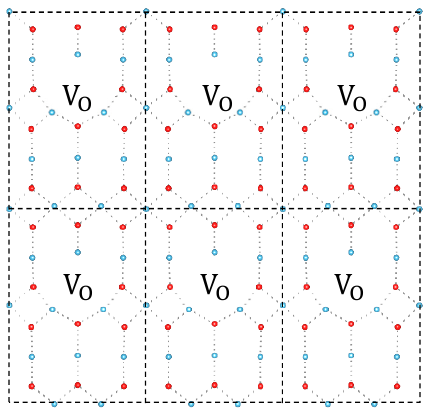
Figure 4. Schematic structure of 2 × 2 × 3 oxygen vacancy structure in periodical method. In the framework of the density functional theory (DFT) method, all calculations are performed in infinite size, which is constructed through periodic replication of input structure.